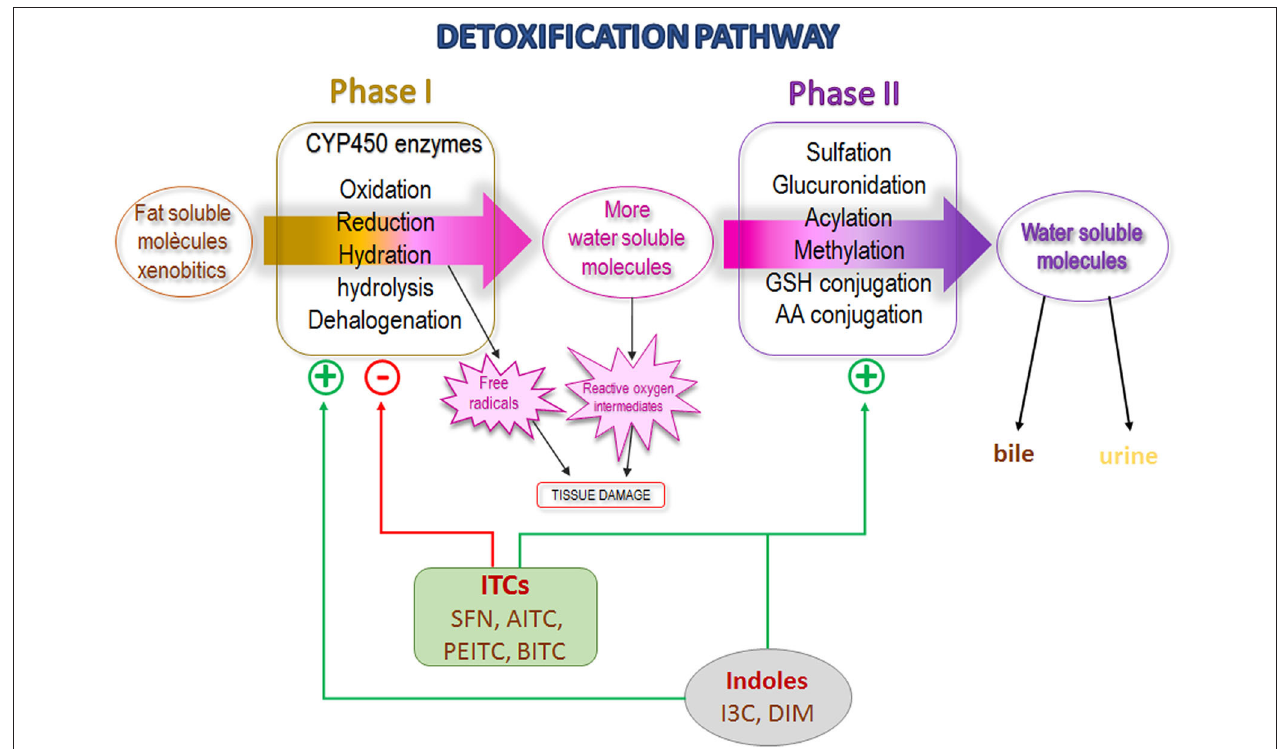
FIGURE 3 | Detoxification pathway scheme showing isothiocyanates and indoles effect. SFN, Sulforaphane; AITC, Allyl isothiocyanate; PEITC, Phenyl isothiocyanate; BITC, Benzyl isothiocyanate; I3C, Indole-3-carbinol; DIM, diindolylmethane.